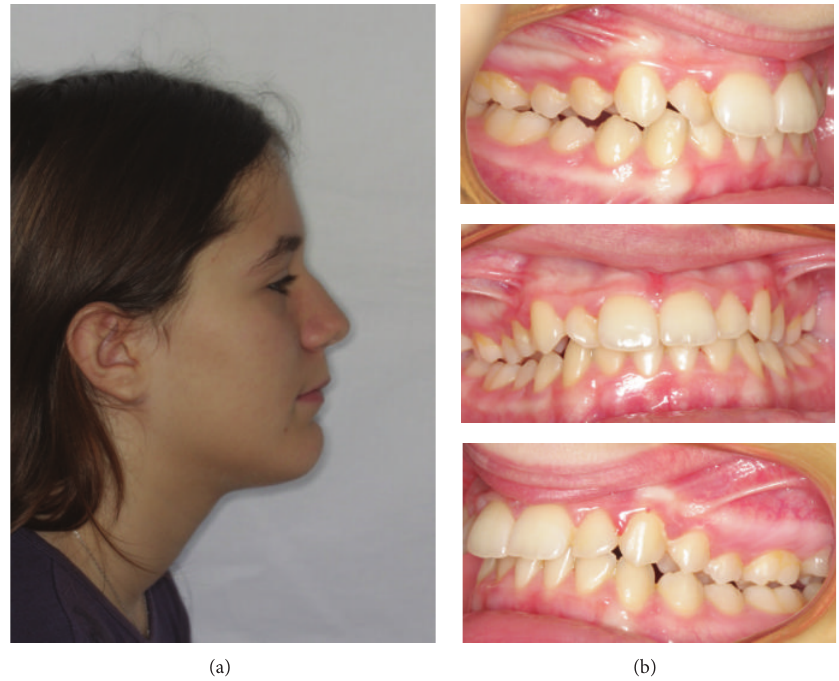
Figure 4: Intermediate records: (a) extraoral profile photo and (b) intraoral photos.